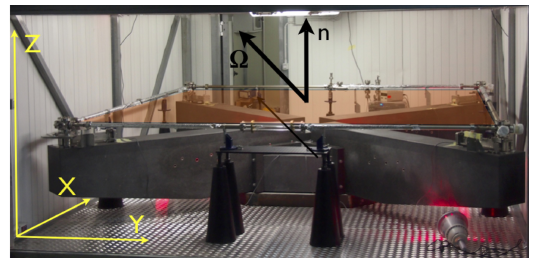
Figure 2: The GINGERino RLG